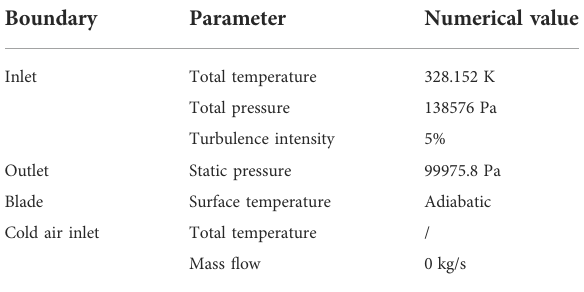
TABLE 2 LISA 1.5 calculation boundary conditions of the turbine